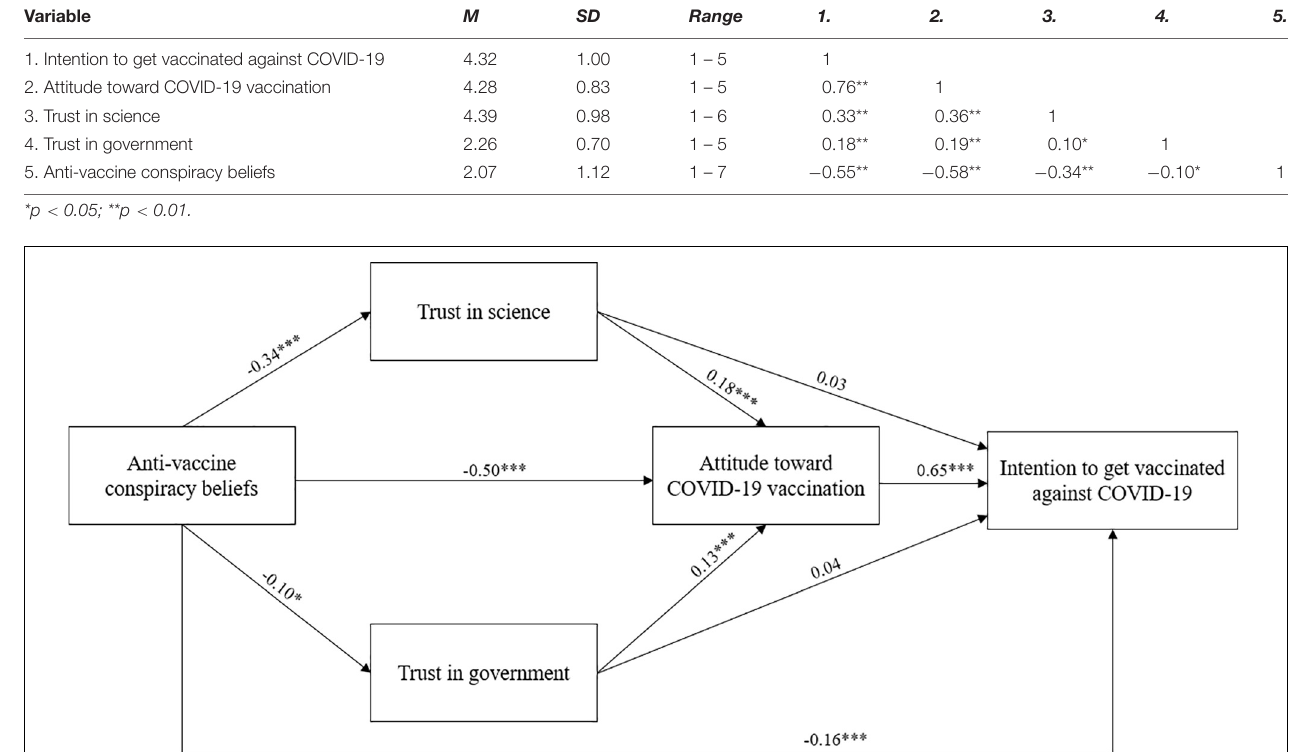
FIGURE 2 | Path analysis model with standardized regression coefficients. * p < .05; *** p <